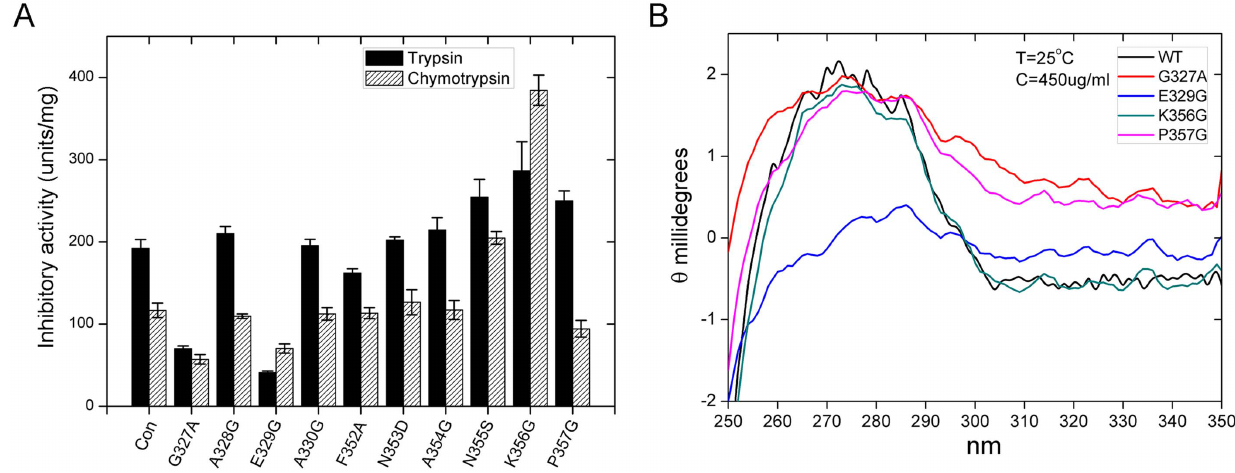
Figure 7. Effects of N- and C-terminal side regions of RCL on the activity of SW-AT-1. (A) Antitrypsin and antichymotrypsin activity. Data analysis was performed using the t-test function (P # 0.05). (B) near-UV CD spectra of WT and mutants.